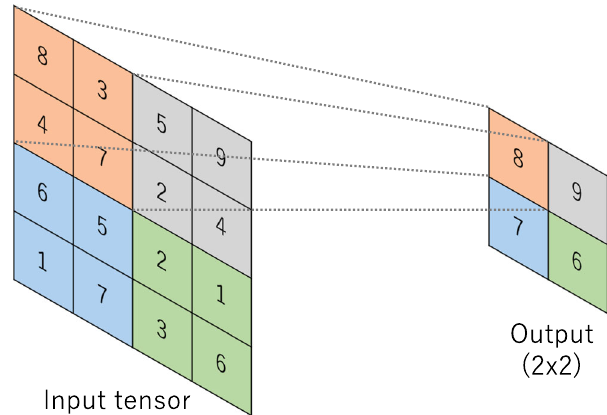
input tensor by a factor of 2. b Examples of the max pooling operation on the same images in Fig. 3b. Note that images in the upper row are downsampled by a factor of 2, from 26 × 26 to 13×